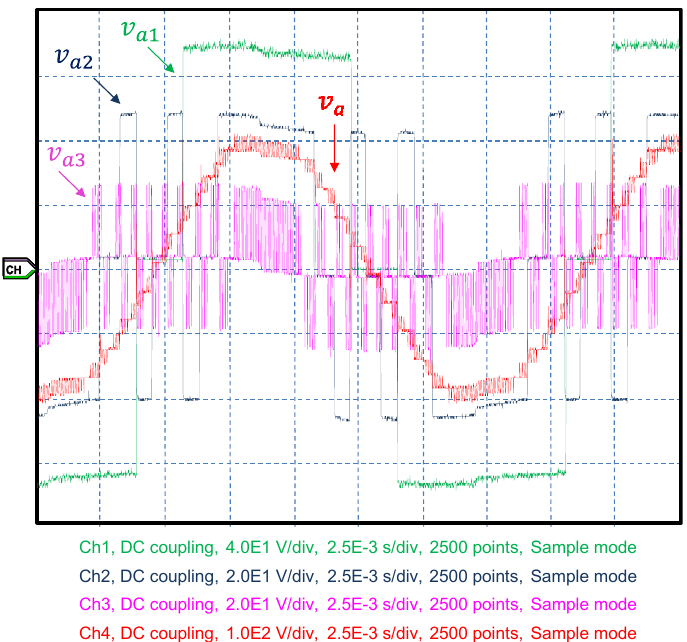
Figure 13. ( a ) Three-phase current converter waveform; ( b ) TDD.